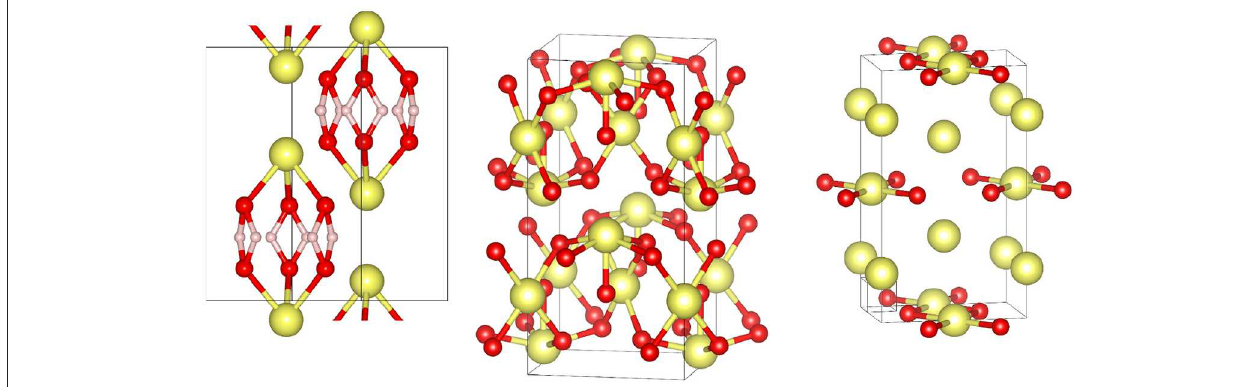
FIGURE 1 | Experimentally observed and theoretically predicted xenon oxides. From left to right: Xe 2 O 6 H 6 [60], Xe 2 O 5 , Xe 2 O 3 [61]. Color code for atoms: xenon (yellow), oxygen (red), hydrogen atoms (light pink).